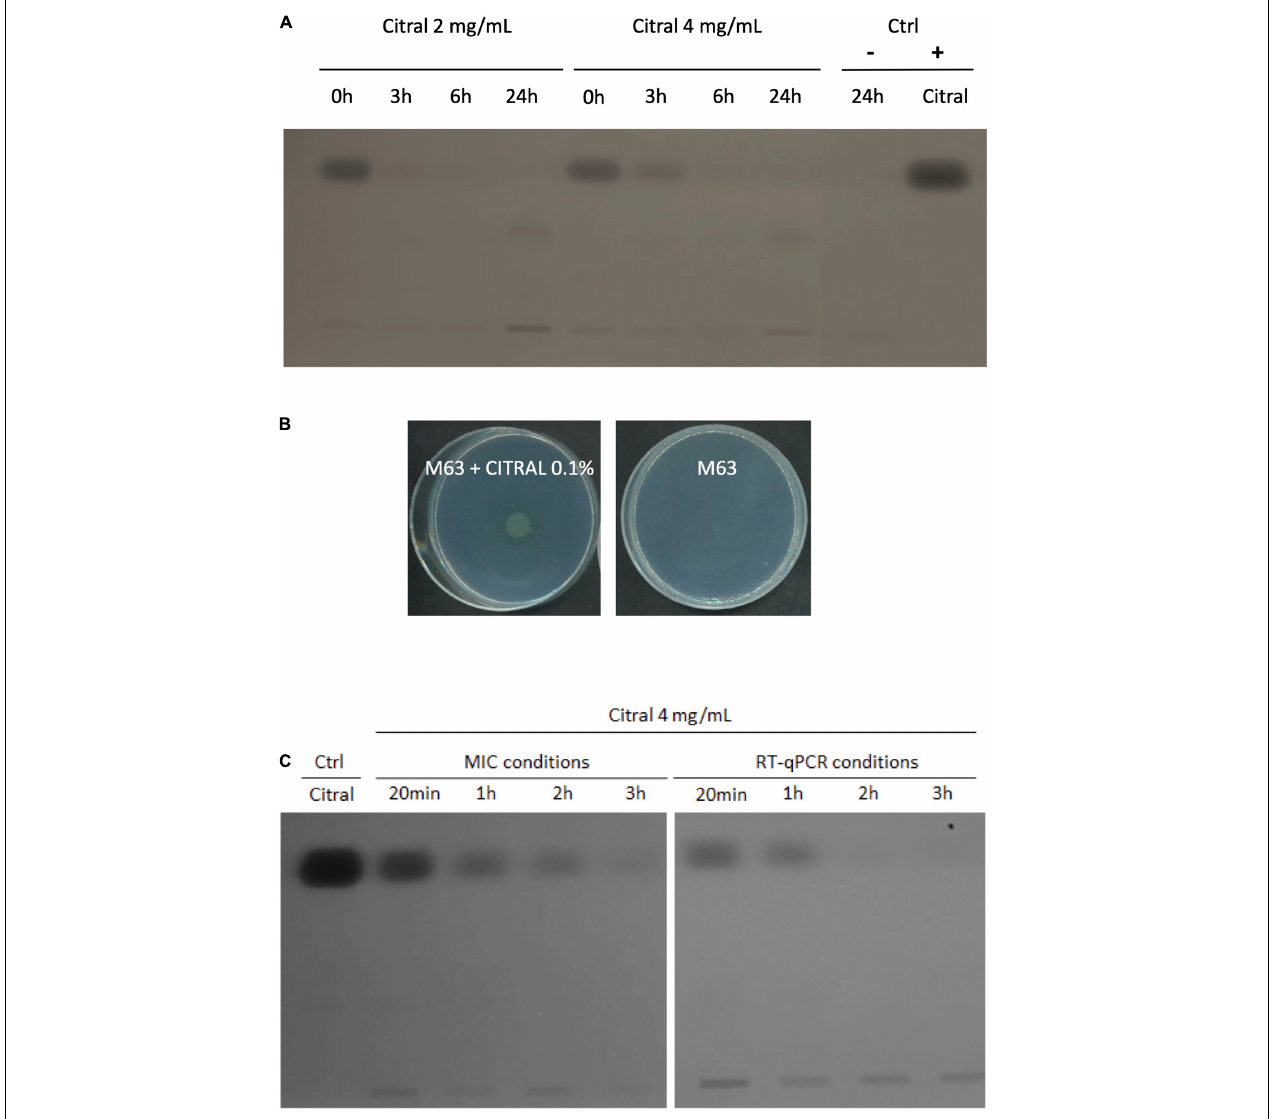
FIGURE 3 | Degradation of citral by P. aeruginosa strain PA14. (A) TLC analysis of culture supernatants of strain PA14 after 0, 3, 6, and 24 h of incubation with 2 or 4 mg/mL citral. Ctrl: supernatant of PA14 growth medium without citral after 24 h (–), citral control sample 5 µ g (+). (B) Growth of PA14 on minimal medium M63 with or without citral as sole carbon source (after 48 h at 37 ◦ C). (C) TLC analysis of citral consumption by using an initial inoculum of 5.10 5 CFU/mL (MICs conditions) or 1.5.10 8 CFU/mL (RT-qPCR conditions) in